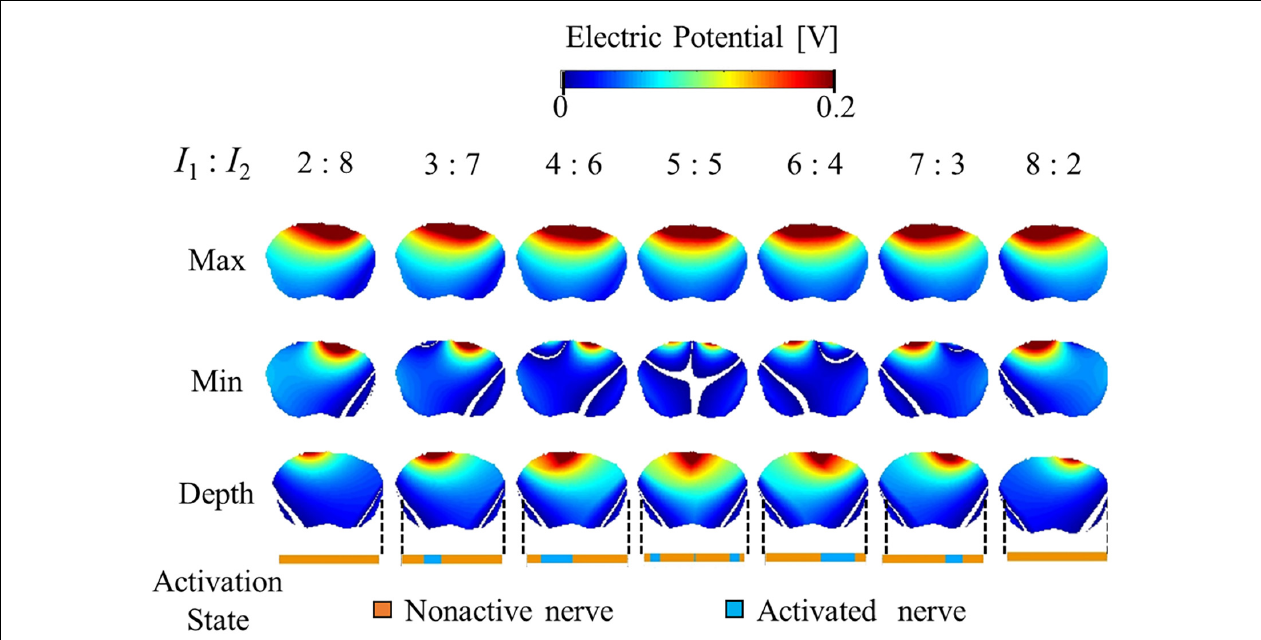
FIGURE 5 | Electric potential distribution of the envelope for three metrics: maximum, minimum, and depth (see definitions in Figure 2 ). Activation state of the axons are indicated.